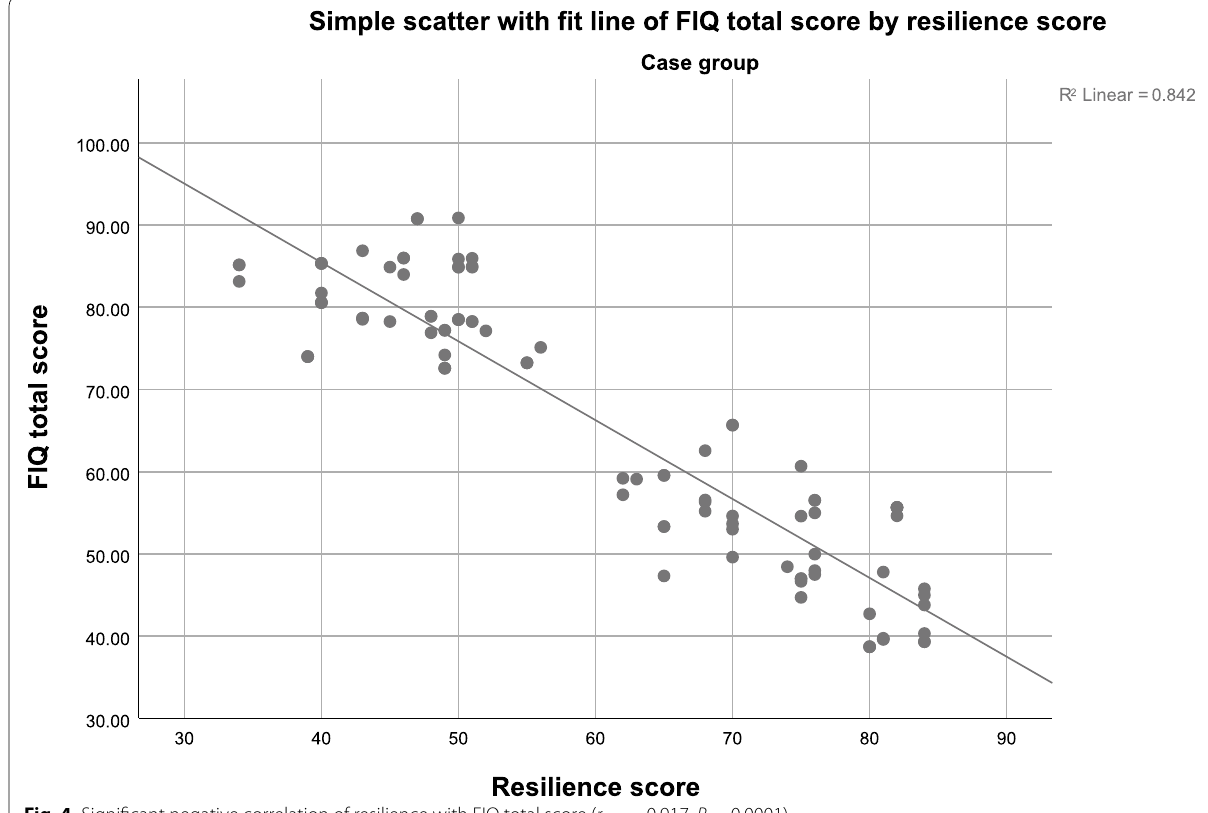
Fig. 4 Significant negative correlation of resilience with FIQ total score ( r